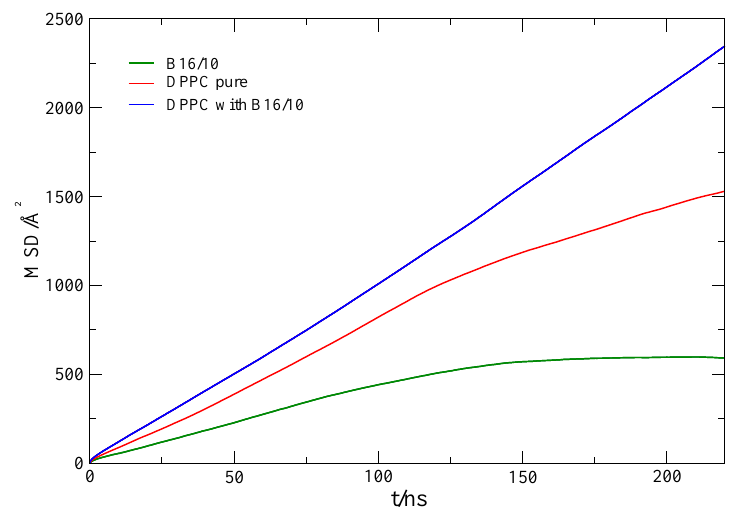
Figure 4. Mean square displacement of lipids in a pure DPPC bilayer (red), the lipids (blue) and B16/10 molecules (green) in the mixed system (lipids/B16/10).